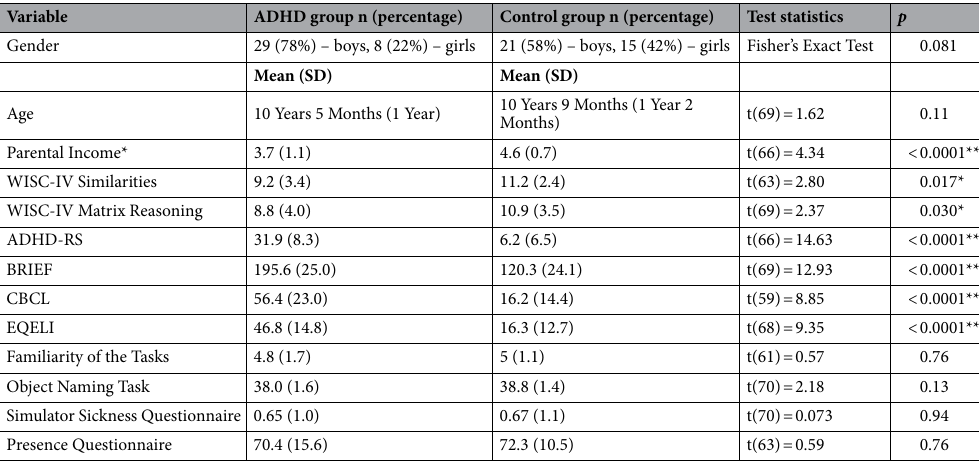
Table 1. Background characteristics of the study sample. ADHD-RS ADHD Rating Scale-IV, BRIEF the Behavior Rating Inventory for Executive, CBCL the Child Behavior Checklist, and EQELI the Executive Questionnaire of Everyday LIfe (see Methods section and Supplementary Methods: EPELI. After-game assessment). * Average parental income before tax was reported as: 1 = less than 1 500 €/m, 2 = 1 500–2 200 €/m,